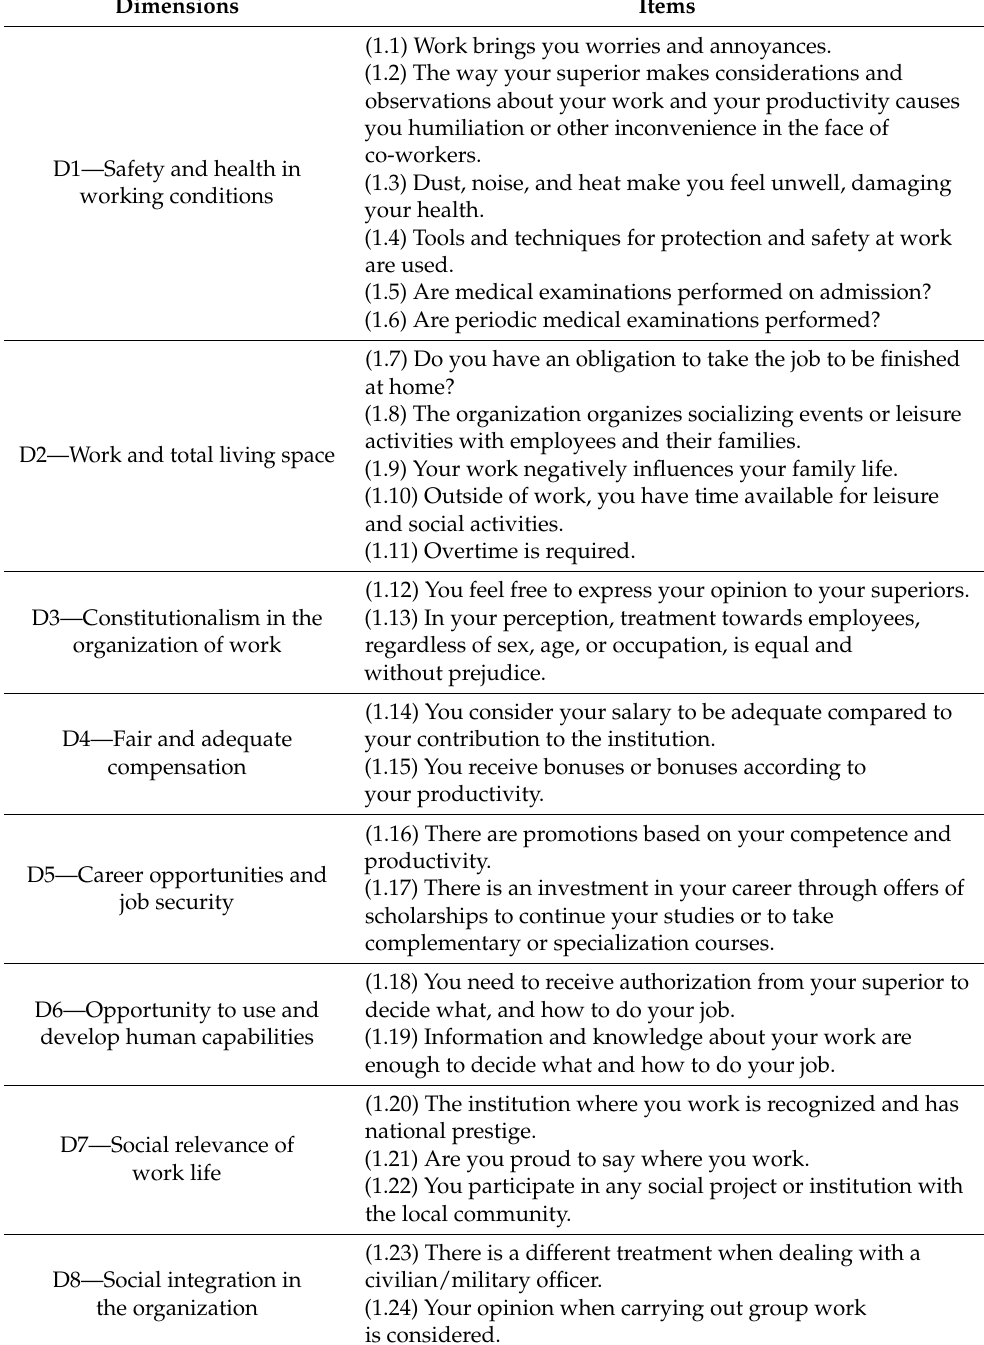
Table 2. Dimensions on the QWL satisfaction level